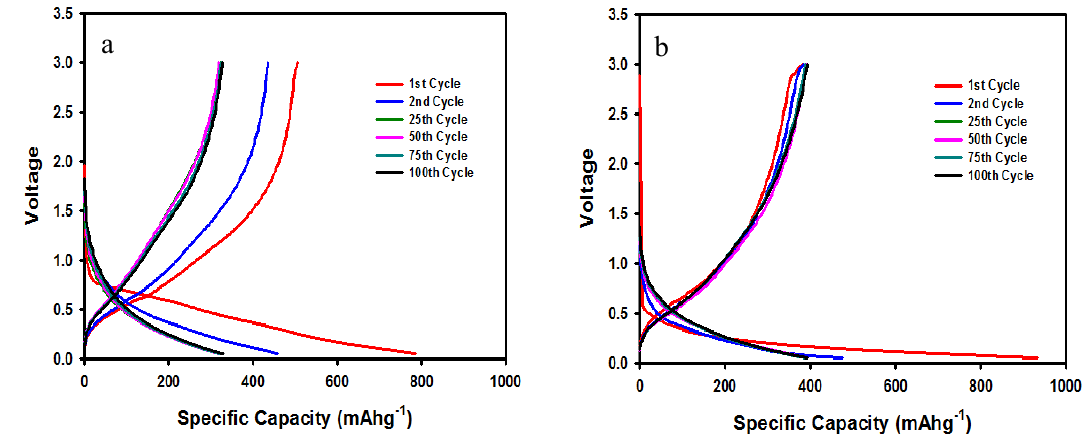
Figure 8. Charge / discharge profiles for a SnO 2 / C composite-fiber anode at 25 ◦ C in two di ff erent Figure 8. Charge/discharge profiles for a SnO 2 /C composite-fiber anode at 25 ° C in two different electrolytes: ( a ) 1M LiPF 6 in EC / DMC (1:1 v / v ) electrolyte, and ( b ) 1 M LiTFSI in 60% EMI-TFSI / 40% electrolytes: ( a ) 1M LiPF 6 in EC/DMC (1:1 v/v) electrolyte, and ( b ) 1 M LiTFSI in 60% EMI-TFSI/ 40% EC / DMC (1:1 v / v ) with 5 wt% SN. EC/DMC (1:1 v/v) with 5 wt% SN.